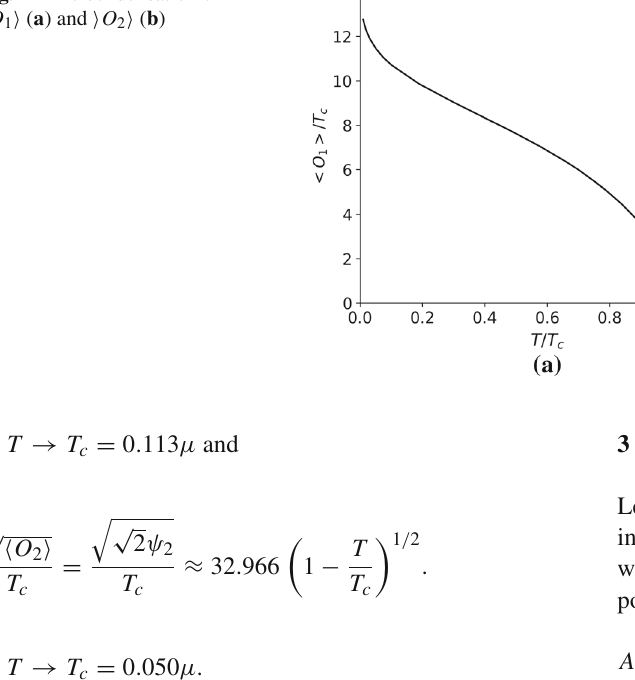
Figure 1 and the foregoing expressions characterise one of the typical properties of superconductors in mean-field approximation. It is worth to note that the phase transition takes place at L = 1, corresponding to pressure P L = 1 =